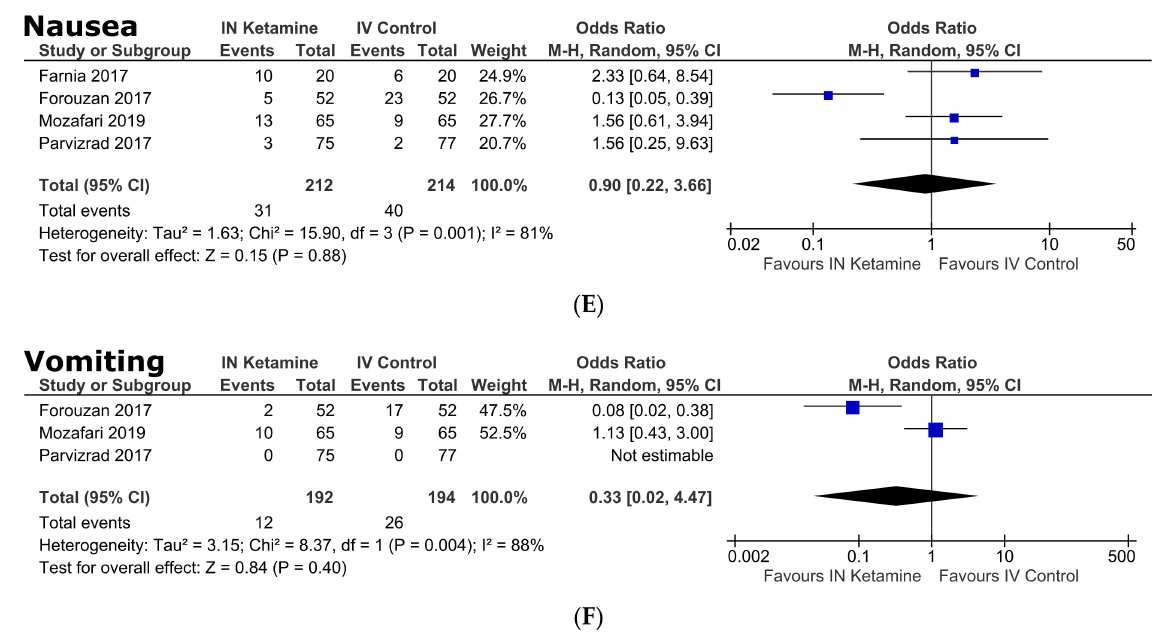
Figure 4. Prevalence ( A – C ) and odds ratio ( D – F ) of dizziness, nausea and vomiting in acute pain patients following administration of IN ketamine in emergency settings.